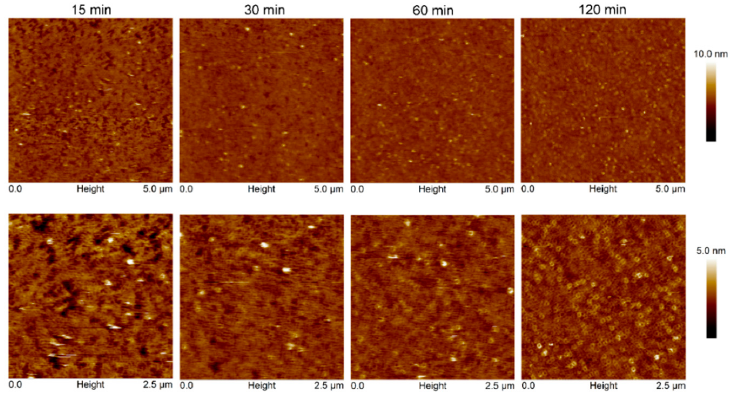
Figure 7. Time sequence AFM images of Cyt2Aa2 protein binding on the lipid bilayer of 5:3 (POPC:Chol) ratio. Once the lipid bilayer formation was confirmed by tip indentation, Cyt2Aa2 protein of 25 µg/mL was introduced into the fluid cell chamber. AFM images were collected in tapping mode with scan rate of 1–2 Hz in 5 µm × 5 µm. The upper panels are the full scan size images and the lower panels are zoom-in images.